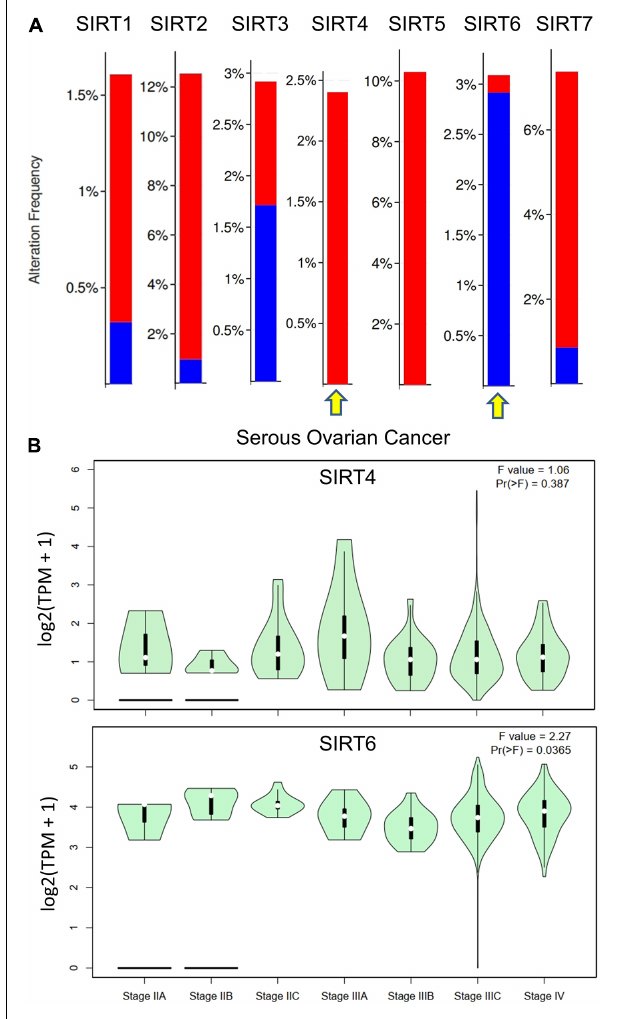
FIGURE 4 | Gene mutation rates of selected sirtuin family members and their association with clinical stages. (A) Bar plot of the mutation rate (proportions) in The Cancer Genome Atlas ovarian cancer (TCGA-OV) data cohort. Red bar indicates copy number variation (CNV) amplification and blue bar indicates deep deletion. Yellow arrow indicates the selected members for downstream analysis. (B) Violin plots of the relationship between SIRT4/SIRT6 expressions and the tumor stages of patients from